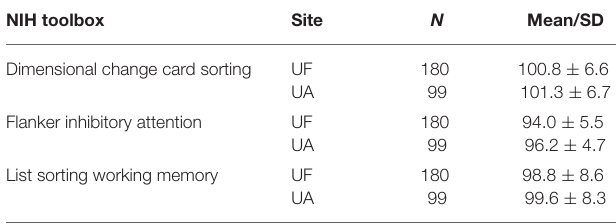
TABLE 2 | NIH toolbox scores by